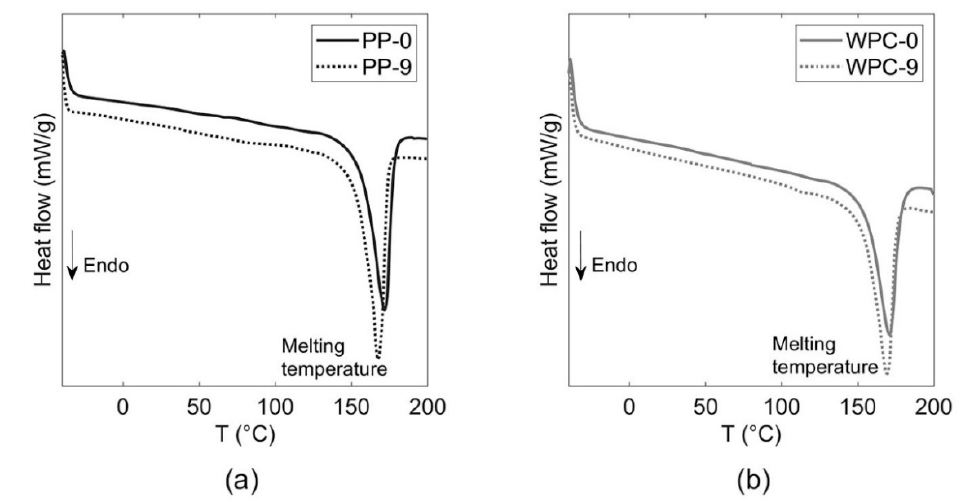
Figure 5. The effect of the heat flow—temperature graphs obtained from the tests performed with the differential scanning calorimetry (DSC) ( a ) PP and ( b ) WPC samples.